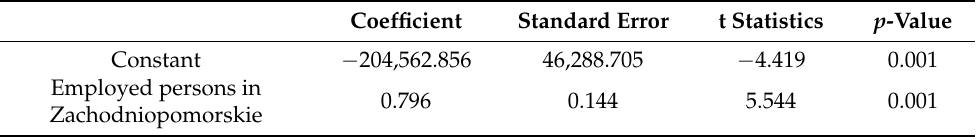
Table 5. Results of estimation of the model for the regional gross product (dependent variable) and employed persons (independent variable) in Zachodniopomorskie (model 10).